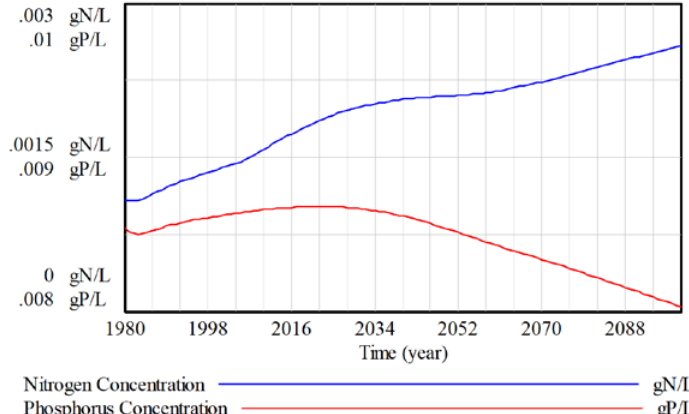
Figure 10. Surface water nutrient concentrations of nitrogen and phosphorus.